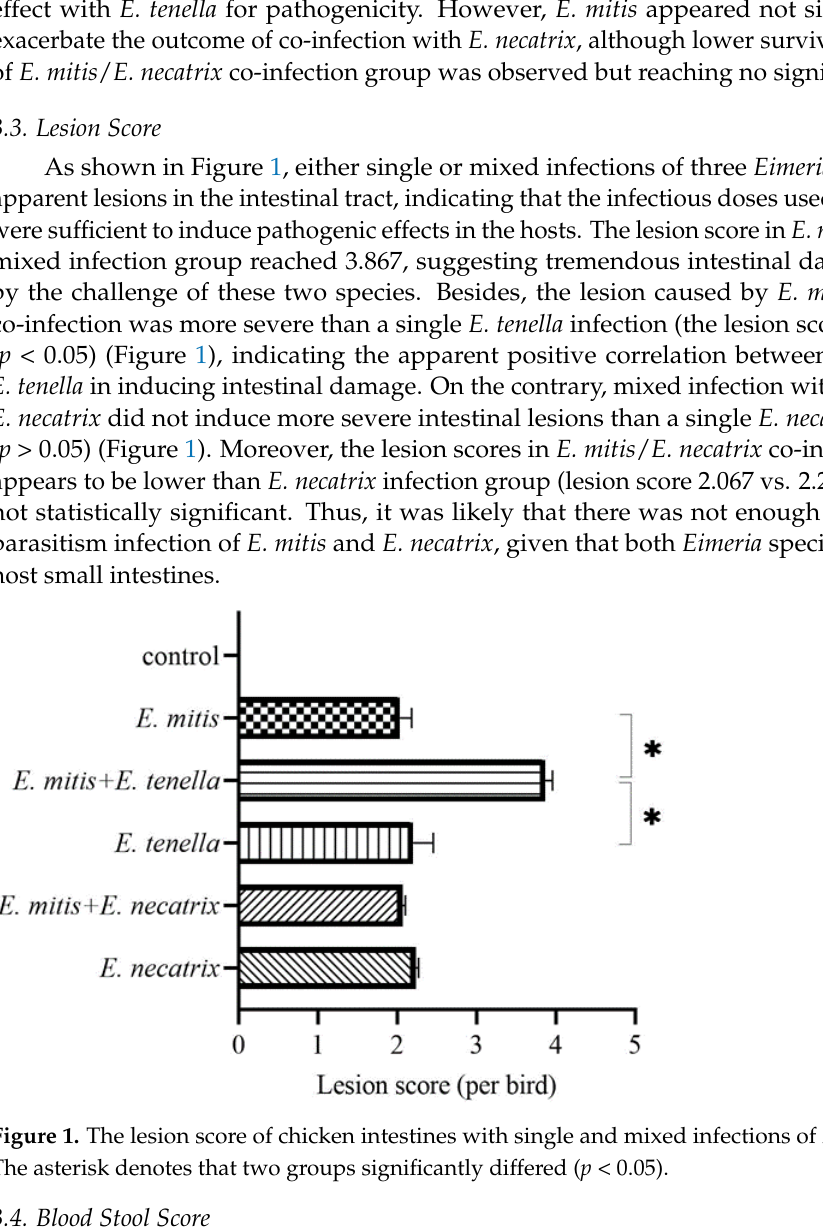
Figure 2. The blood stool score of chickens with single and mixed infections of Eimeria species. 3.5. The Oocyst Output The presence of E. necatrix , E. tenella , and E. mitis oocysts in the feces of varying challenged groups were validated by preferentially amplifying the internal transcribed spacer 1 (ITS-1) regions. The PCR assays detected the E. mitis population in the E. mitis infection group (Figure 3a, lane 1; approximately 306 bp), mixed E. mitis / E. tenella infection group (Figure 3a, lane 2; approximately 306 bp), and E. mitis / E. necatrix co-infection group (Figure 3a, lane 4; approximately 306 bp). In addition, the E. tenella population was only identified in E. tenella -infection group (Figure 3a, lane 2; approximately 278 bp) and mixed E. mitis / E. tenella infection group (Figure 3a, lane 3; approximately 278 bp). Moreover, E. necatrix population was solely found in the E. necatrix infection group (Figure 3a, lane 4; approximately 383 bp) and E. mitis / E. necatrix co-infection group (Figure 3a, lane 5;